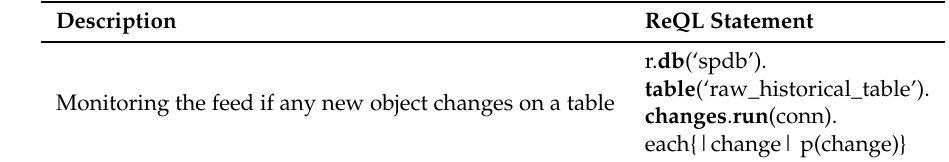
table (‘raw_historical_table’). changes . run (conn).